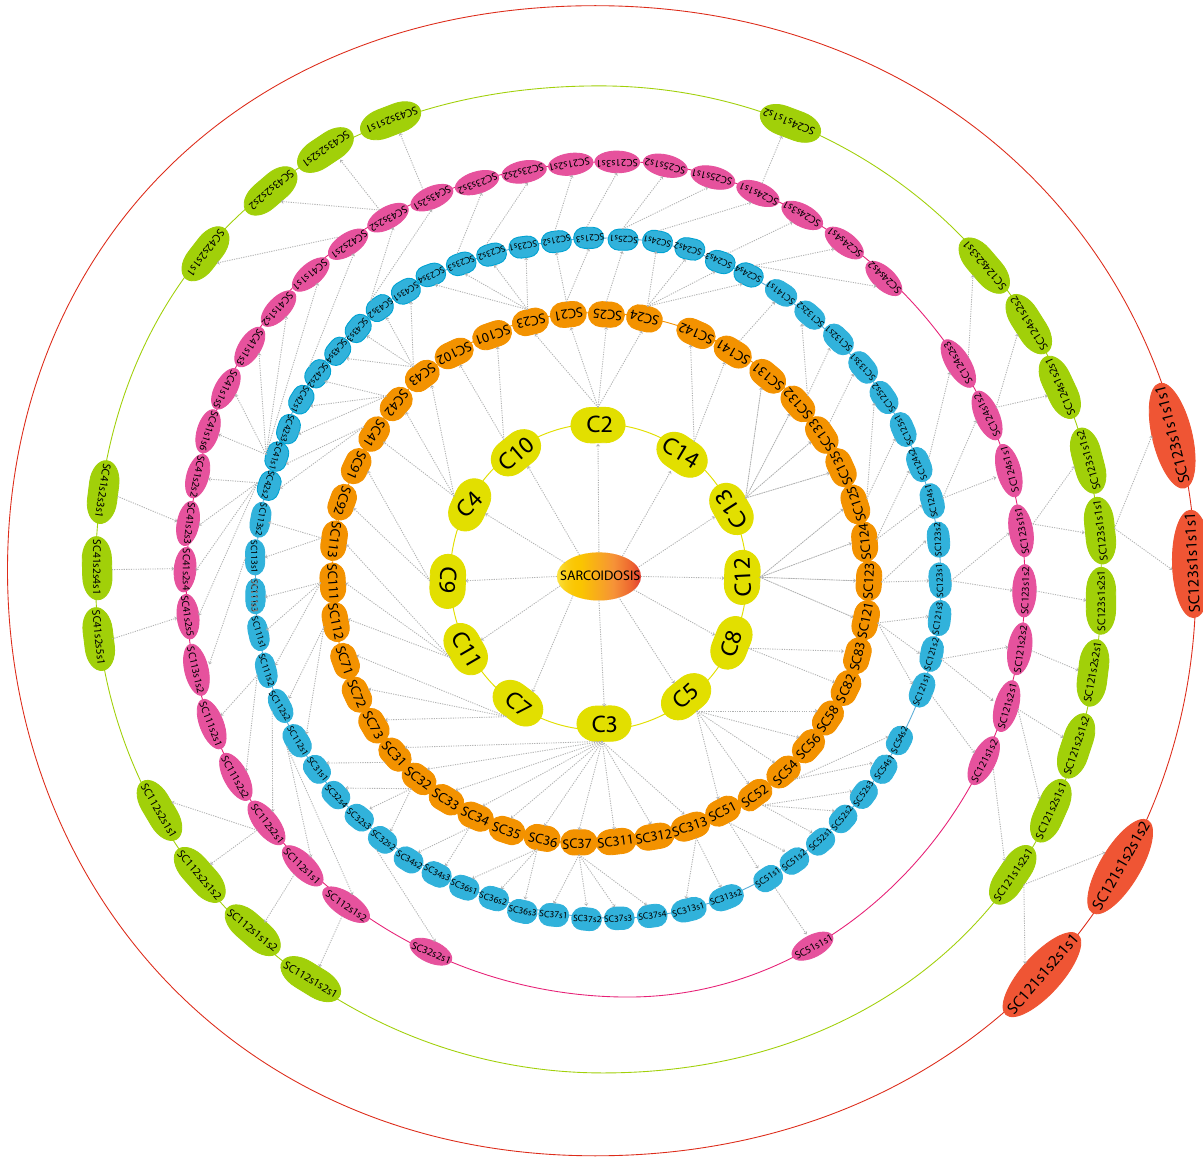
Figure 3. Representation of the organization of the SARC network/communities/sub-communities at six various levels, and arrows indicate sub-communities constructed from the previous